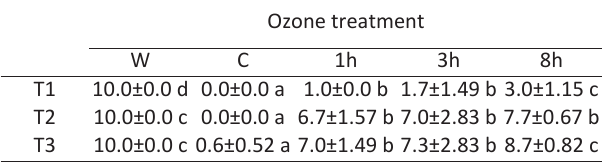
Table 3 - Average number of seed germinated per Petri dish (ten seeds) with different treatments (W, C, OOMW 1h, 3h, 8h) after 1 (T1), 3 (T2), and 6 days (T3), respec- tively